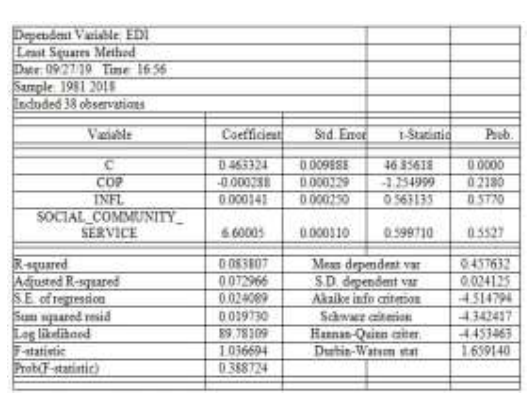
Table 4: Model 2 (Least Square Method of Analysis) (1)